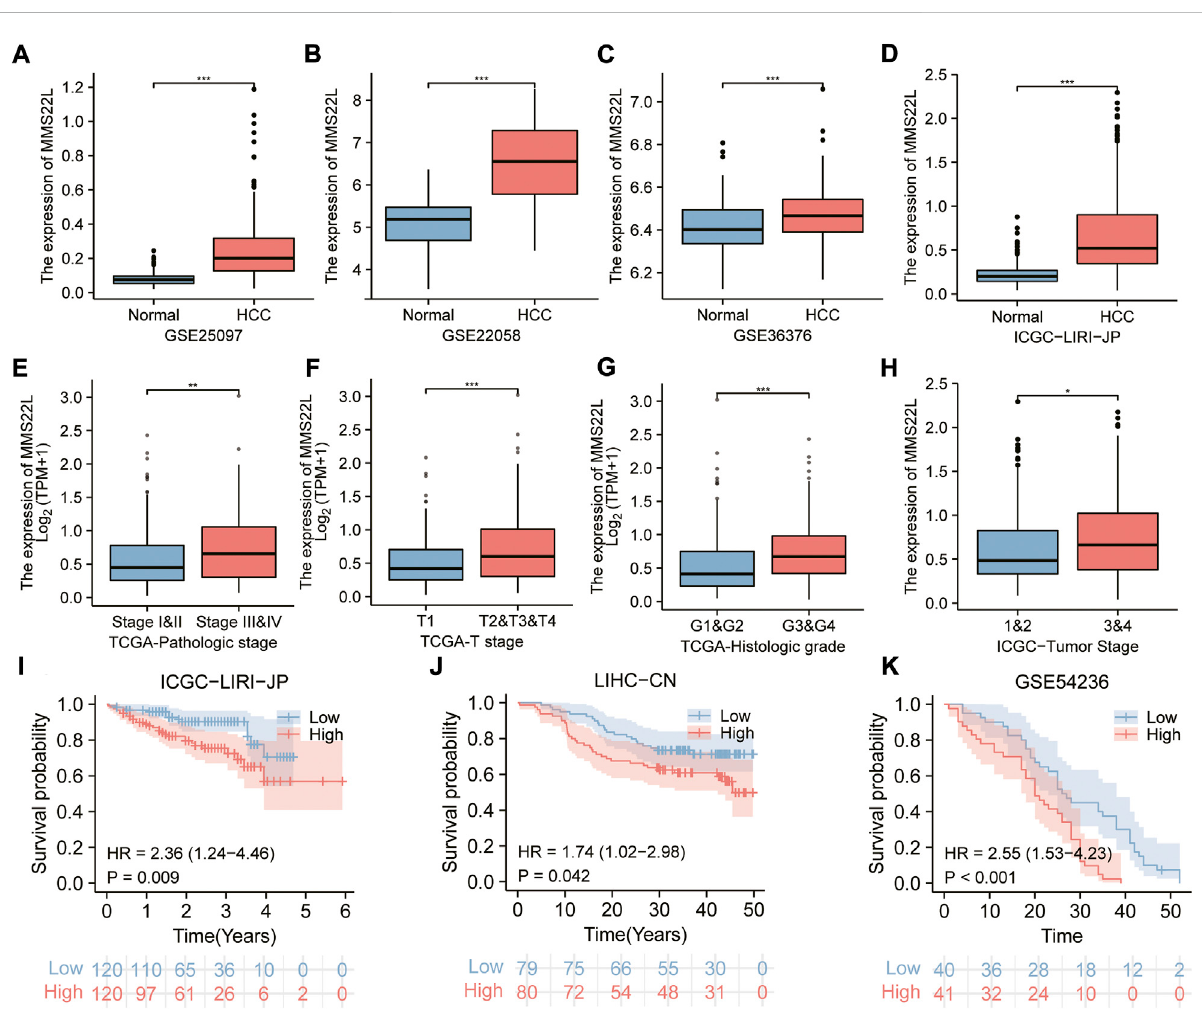
FIGURE 7 The correlation of methyl methanesulfonate-sensitivity protein 22-like (MMS22L) expression with clinical parameters in hepatocellular carcinoma (HCC). (A – D) Boxplot for multiple HCC cohorts showing the higher mRNA expression of MMS22L in tumor tissues than in non-tumor tissues. (E – H) The elevatedlevel of MMS22L expression is associated with a higher degree of malignancy in HCC. (I – K) The Kaplan – Meier